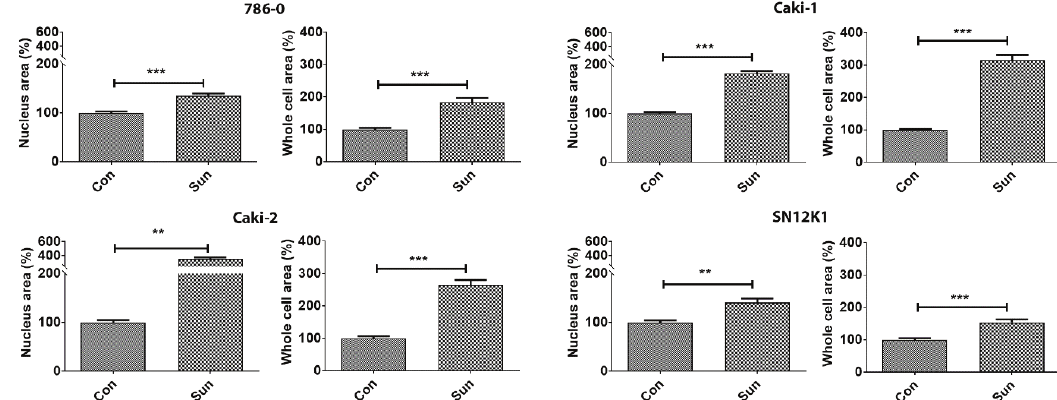
Figure 1. Sunitinib-resistant cells are hypertrophic. RCC cell lines that are resistant to 10 µM of sunitinib showed signifi- cant increases in the surface areas of the whole cells and the nuclei. Results are presented as percentage of the control group. **P < 0.01 and ***P <